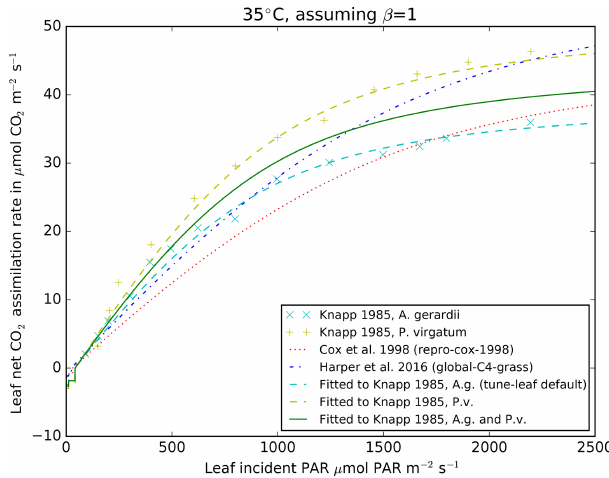
Figure 4. V cmax against leaf temperature for A. gerardii (cyan di- agonal crosses) and P. virgatum (yellow vertical crosses), using the normalised observations from Fig. 2 in Knapp (1985), scaled us- ing the fitted light response curves of A. gerardii and P. virgatum at 35 ◦ C shown in Fig. 3. JULES parameters are fitted to these derived A. gerardii observations (cyan dashed line) and P. virgatum obser- vations (yellow dashed line) and a combination of both (green solid line). Also shown are the relations from the repro-cox-1998 (red dotted line) and global-C4-grass runs (blue dot-dashed line). Model lines have been created using the Leaf Simulator pack-